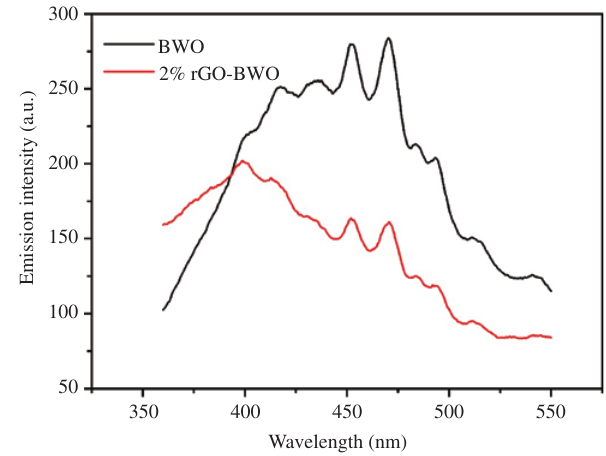
Figure 7: PL spectra of pure Bi